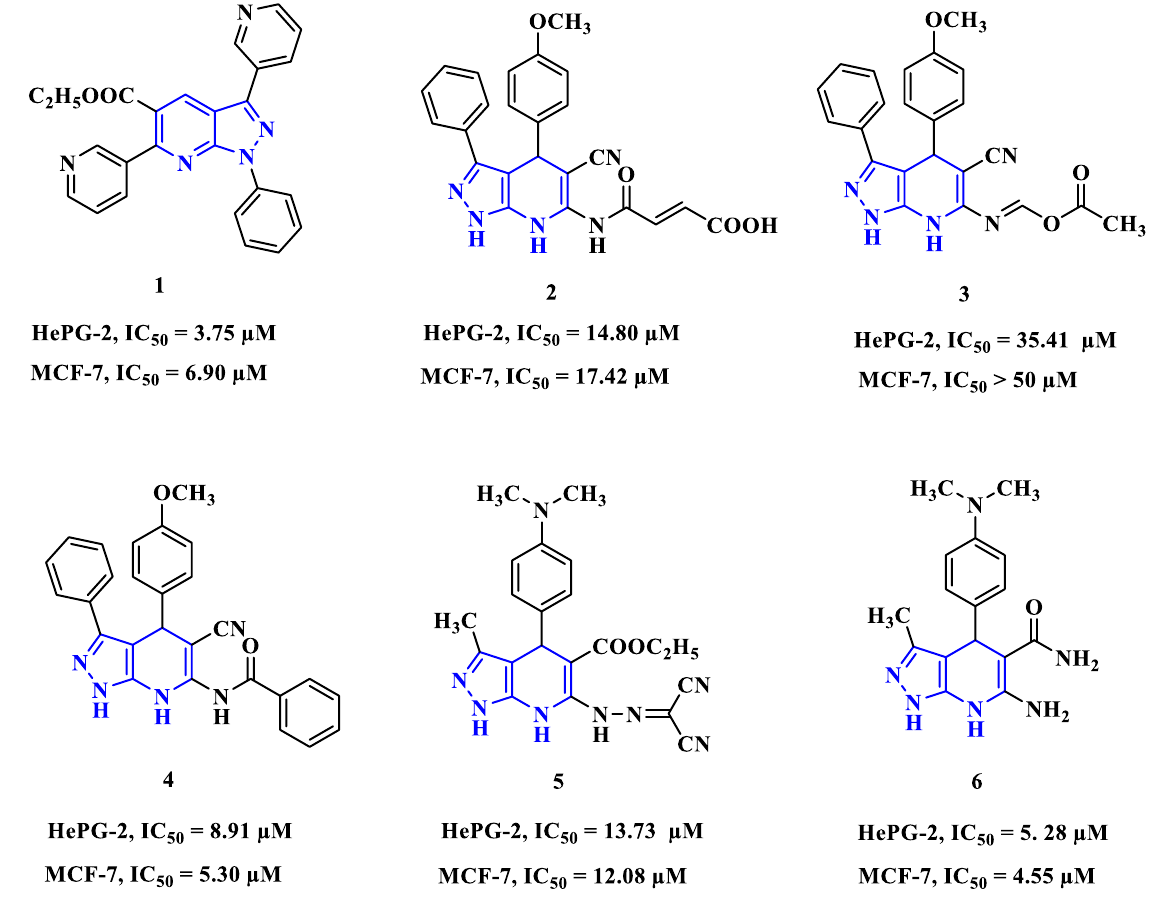
Figure 1. Anticancer activity of some known pyrazolopyridine